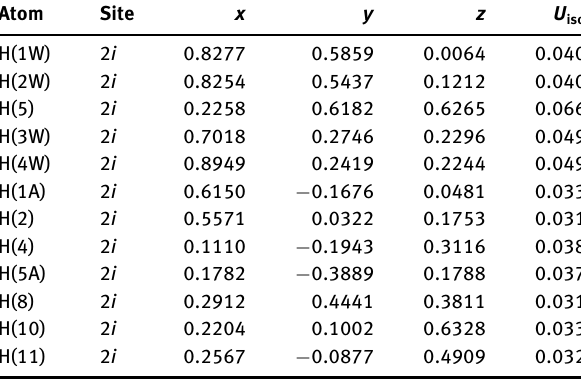
Table 2: Fractional atomic coordinates and isotropic or